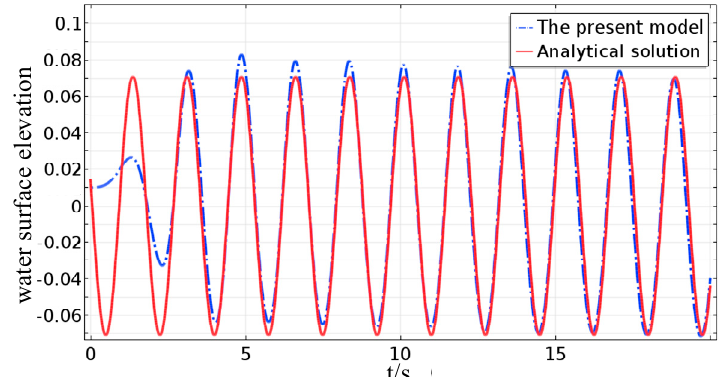
Figure 2. The comparison of the water surface elevation in the present wave model and analytical solution.